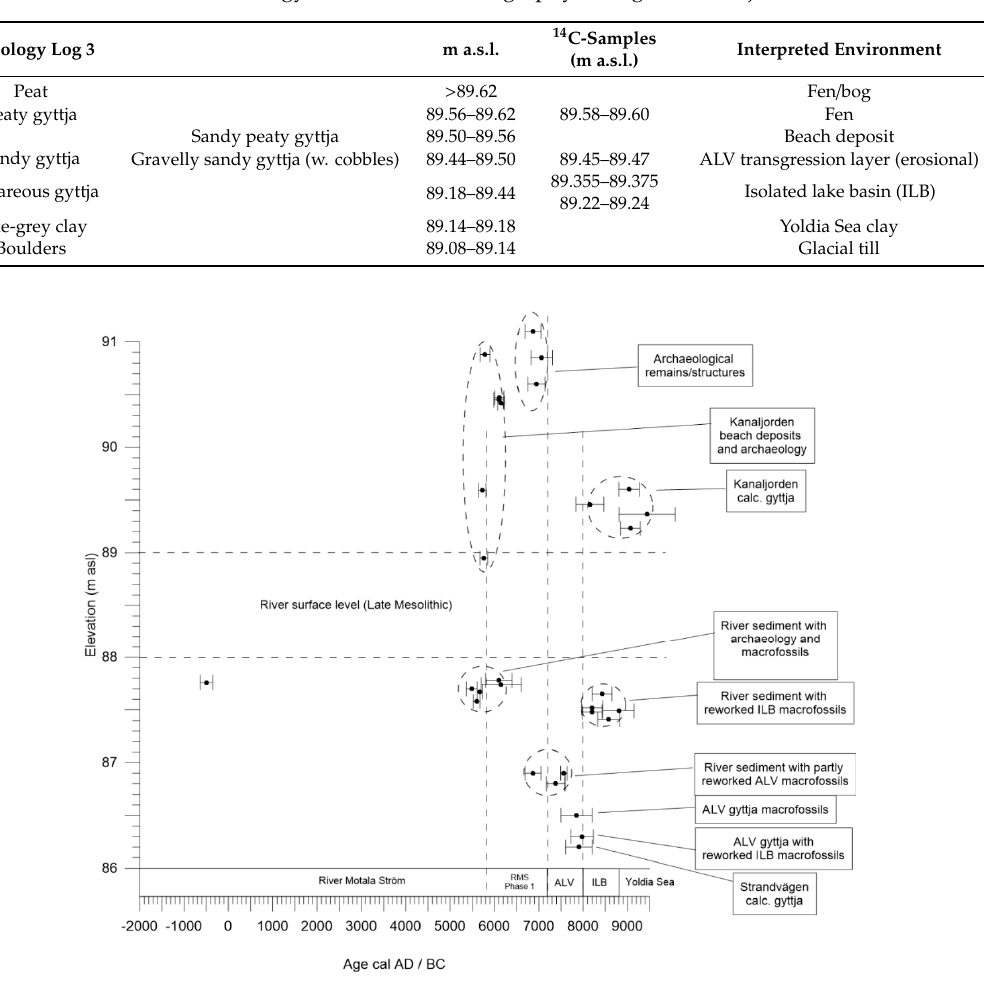
Table 3. Lithology and sediment stratigraphy of Log 3 at